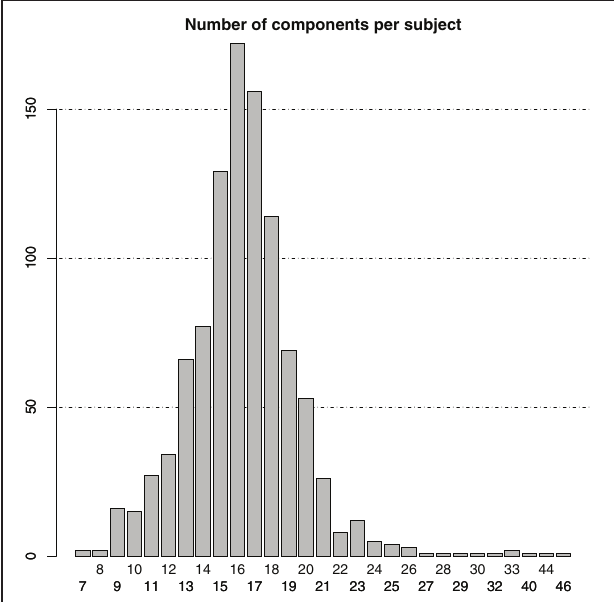
FIGURE 1 | Bar plot of the distribution of the number of components in the individual-subject ICA results.